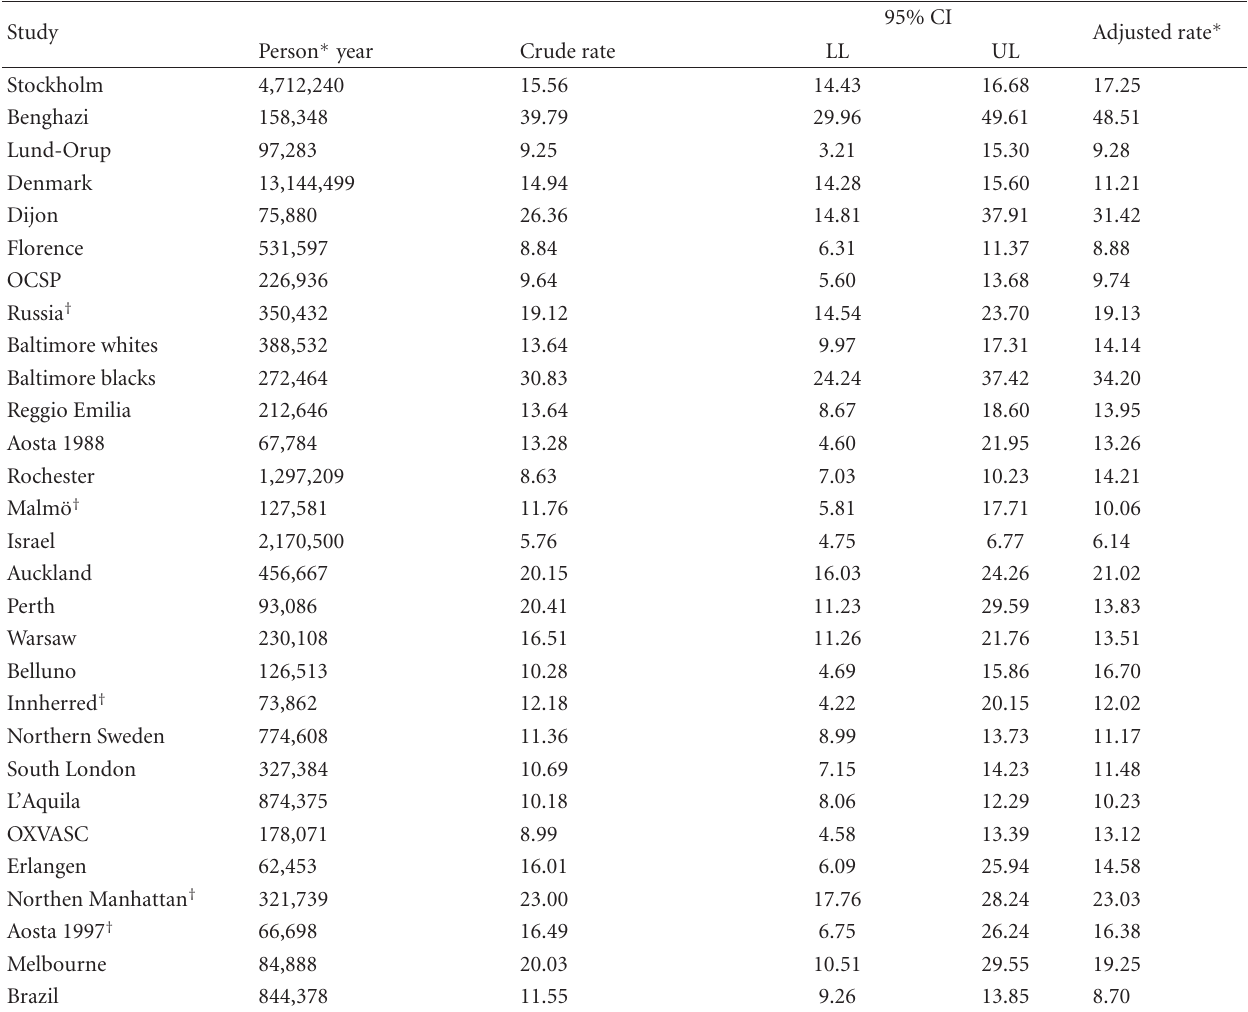
Table 1: Studies on incidence of stroke in the young.